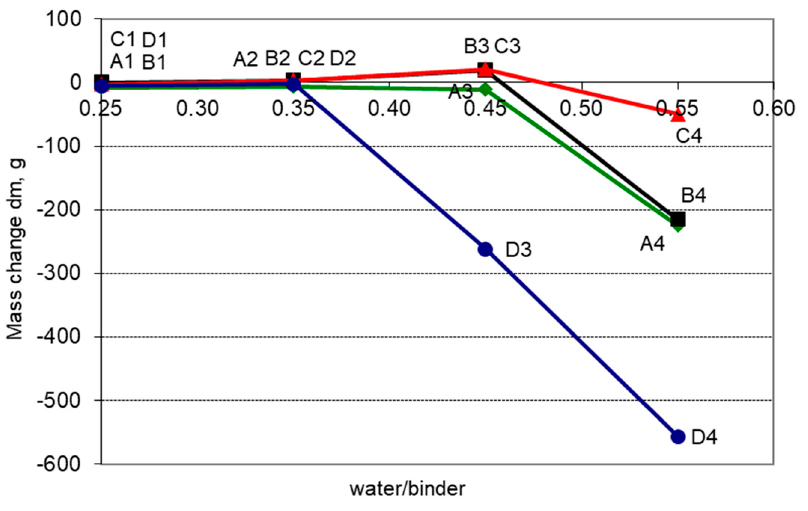
Figure 8. Influence of the w/b ratio and the GGBS content on mass loss, dm.